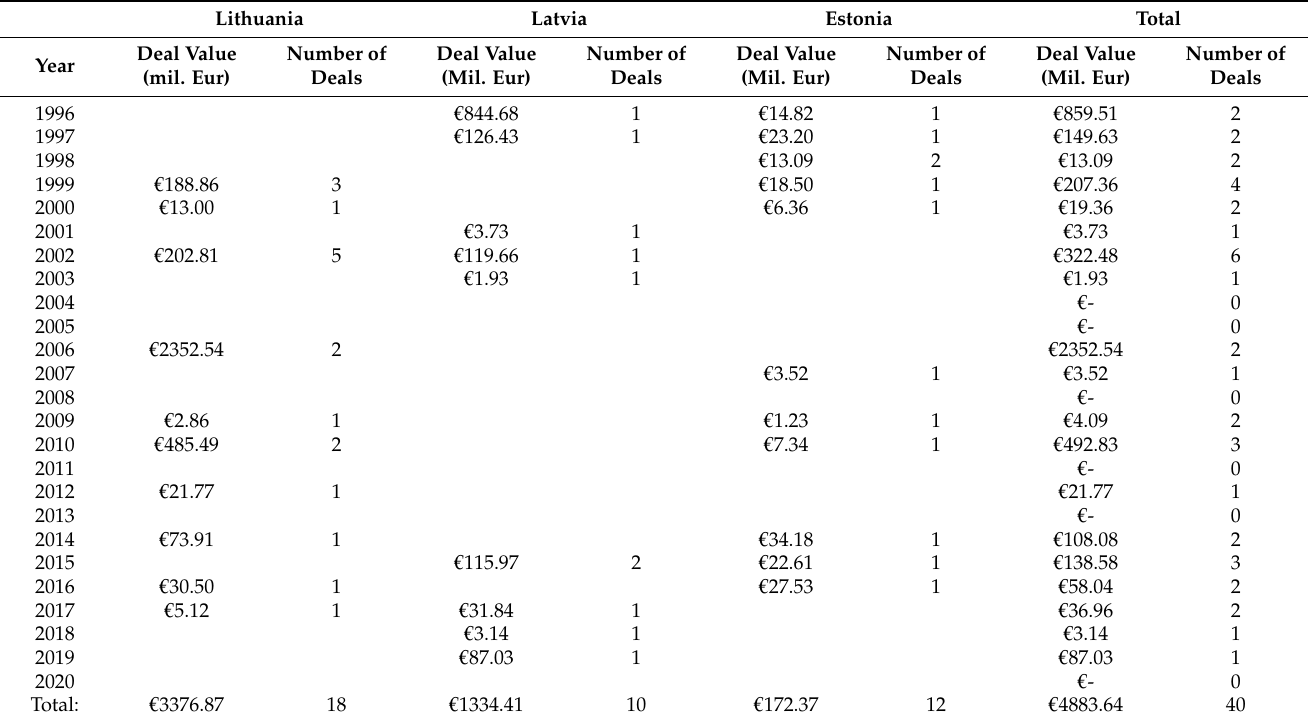
Table A1. Breakdown of annual deal value and volume of energy M&A in the Baltic